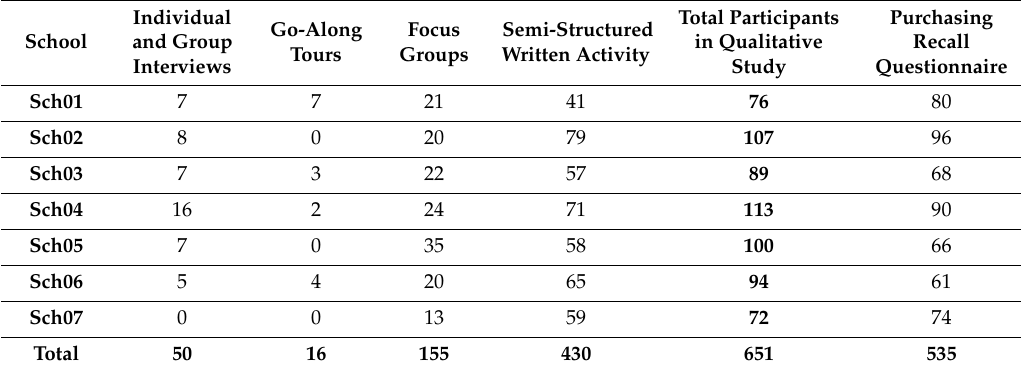
Table 1. Number of young people who participated in the